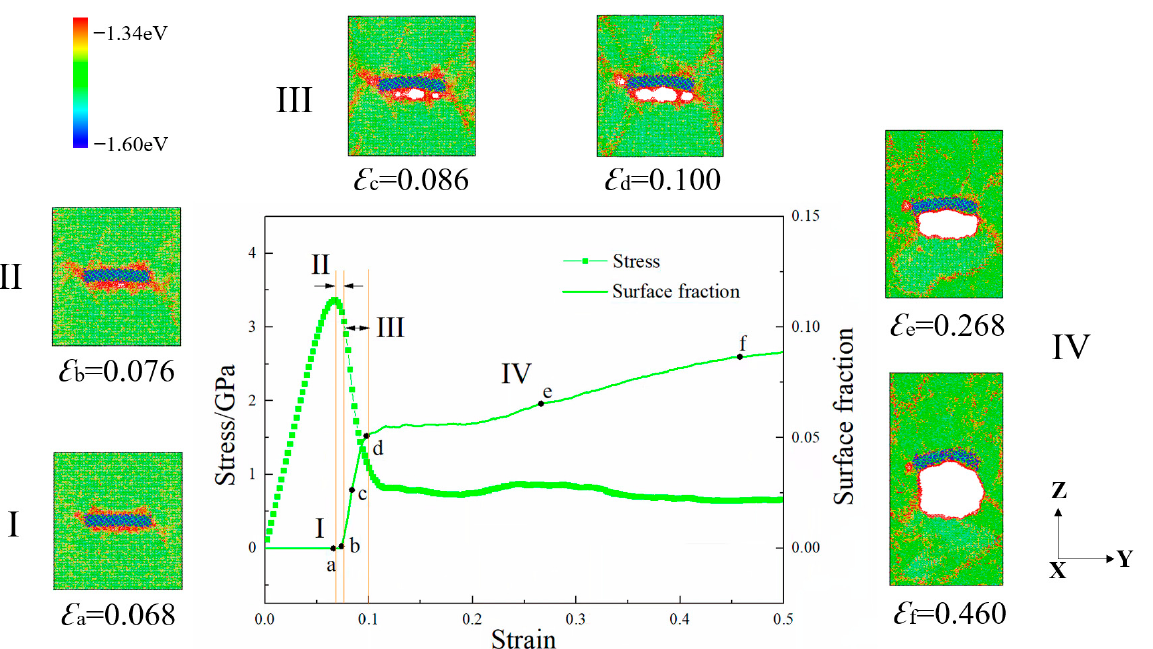
Figure 3. Stress vs. strain and free surface fraction vs. strain relationships of a single-crystal system with a single Mg 17 Al 12 during tensile process. with a single Mg 17 Al 12 during tensile